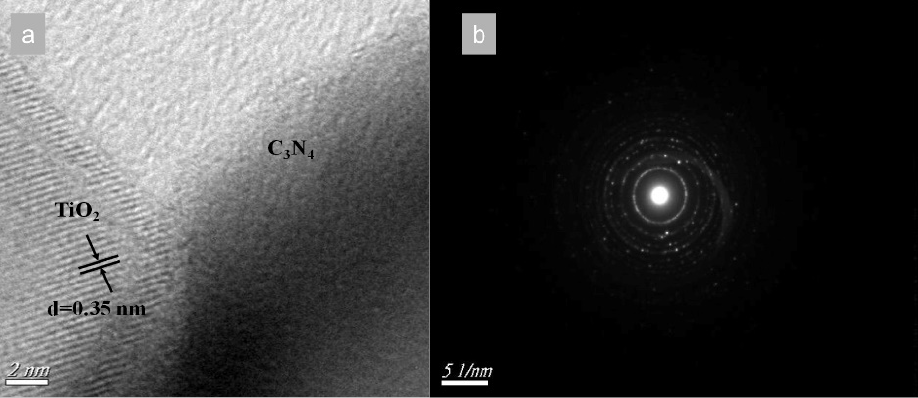
Figure 24. The HR − TEM image ( a ) and SAED pattern ( b ) of C 3 N 4 /TiO 2 composite photocatalysts [177].